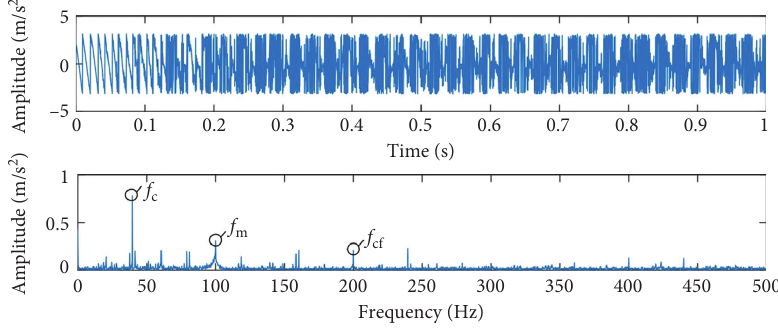
Figure 15: Signal processed by TFSR.